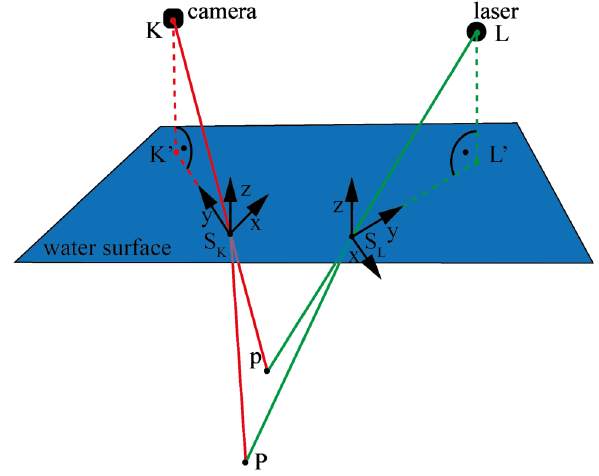
Figure 6. Principles of the ray-based correction approach. The point p is the initial reconstructed point using light section without accounting for refraction and the point P is the point after refractive correction. K is the camera and L the laser projection center. K ′ and L ′ are the projections of the camera and laser center along the water plane normal on the water plane. S K and S L are the respective intersections between the camera and laser ray with the water